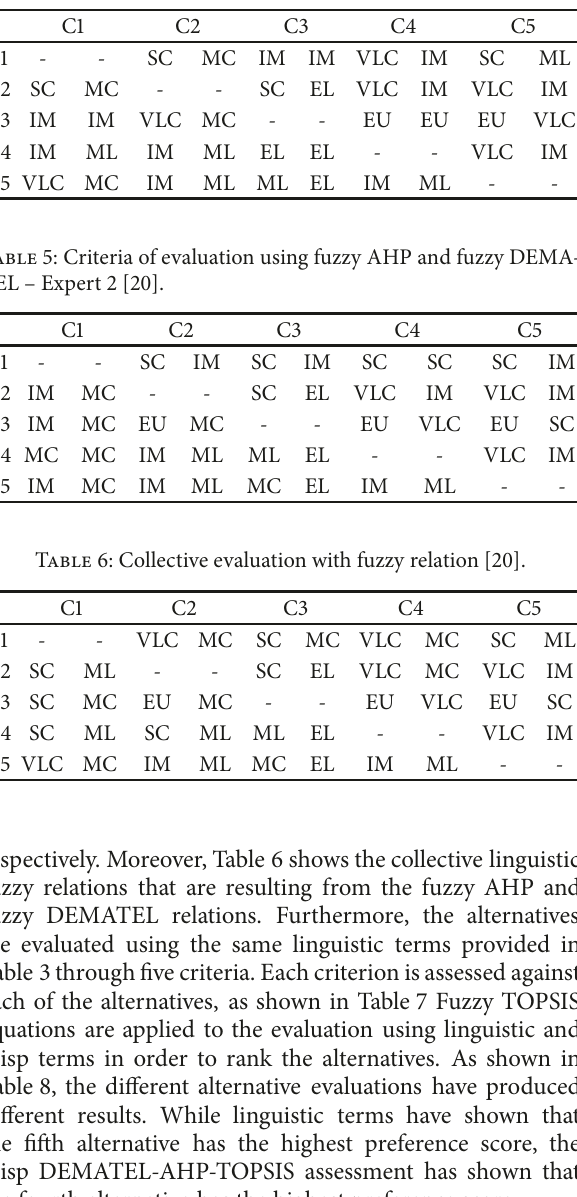
Table 4: Criteria of evaluation using fuzzy AHP and fuzzy DEMA-